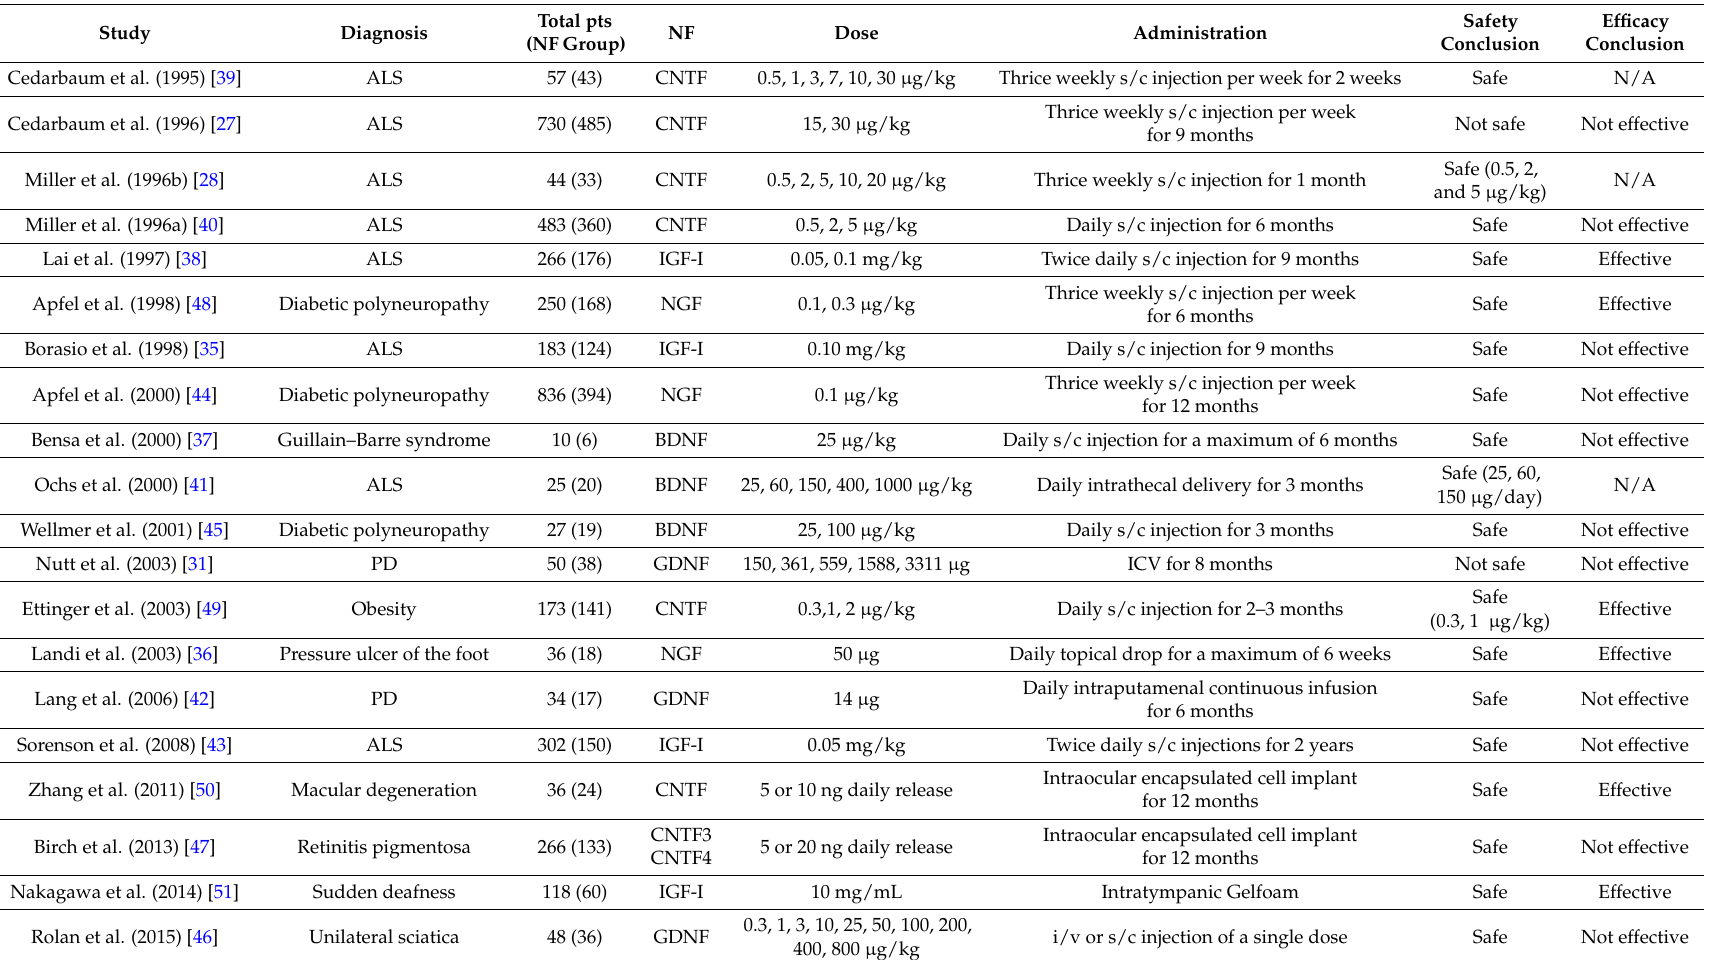
Table 3. Outcome data extracted from included studies using neurotrophic factors in human